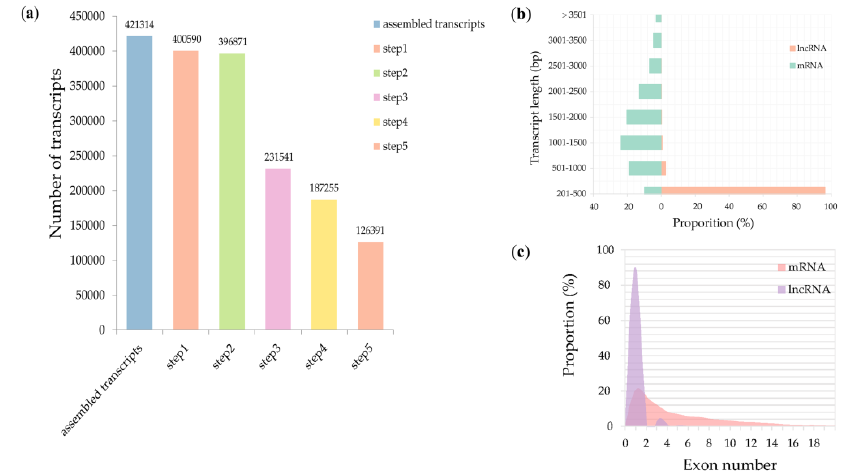
Figure 1. Identification and characterization of long noncoding RNAs (lncRNAs). ( a ) Statistics of